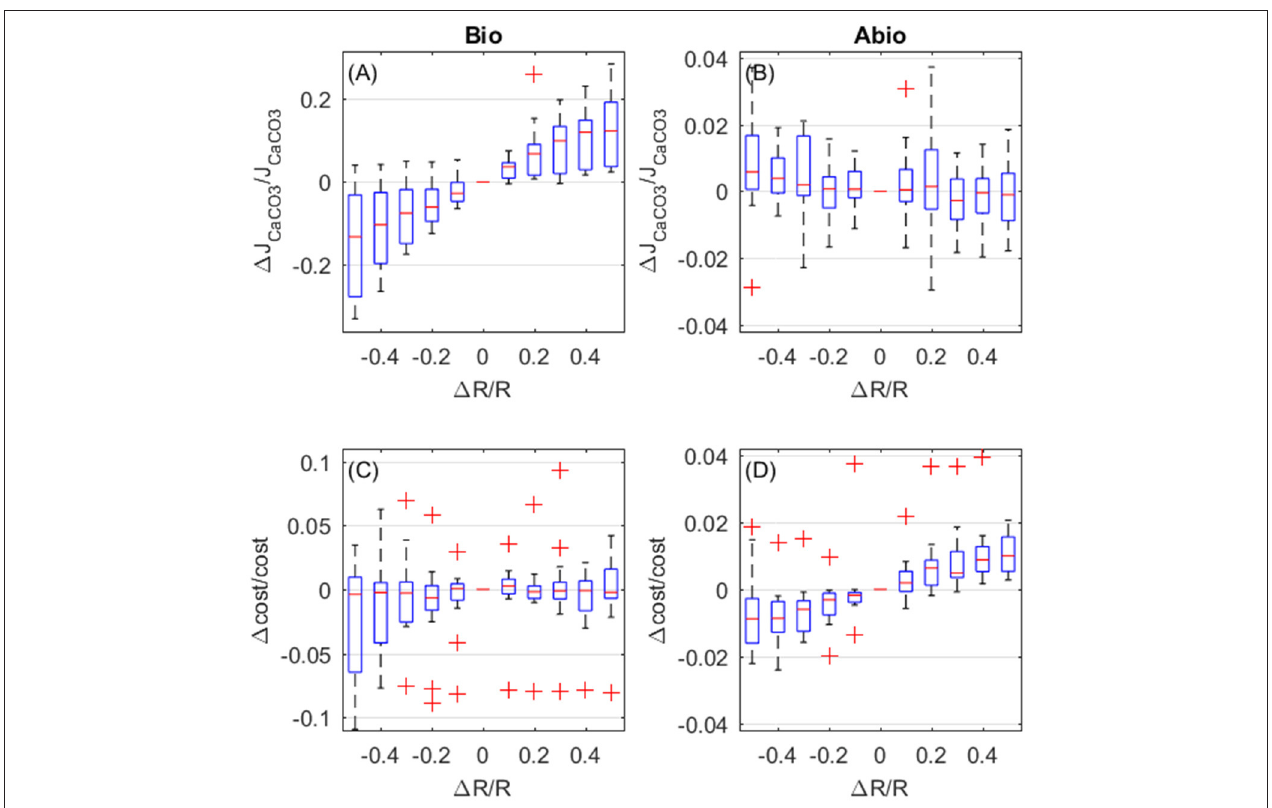
FIGURE 7 | Biologically-mediated (A,C) and abiotic (B,D) effects of respiration, fractional change in calcification rates (top panels) and calcification costs (bottom panels). X and y-axis values are indicative of fractional change. Each boxplot represents all setups.